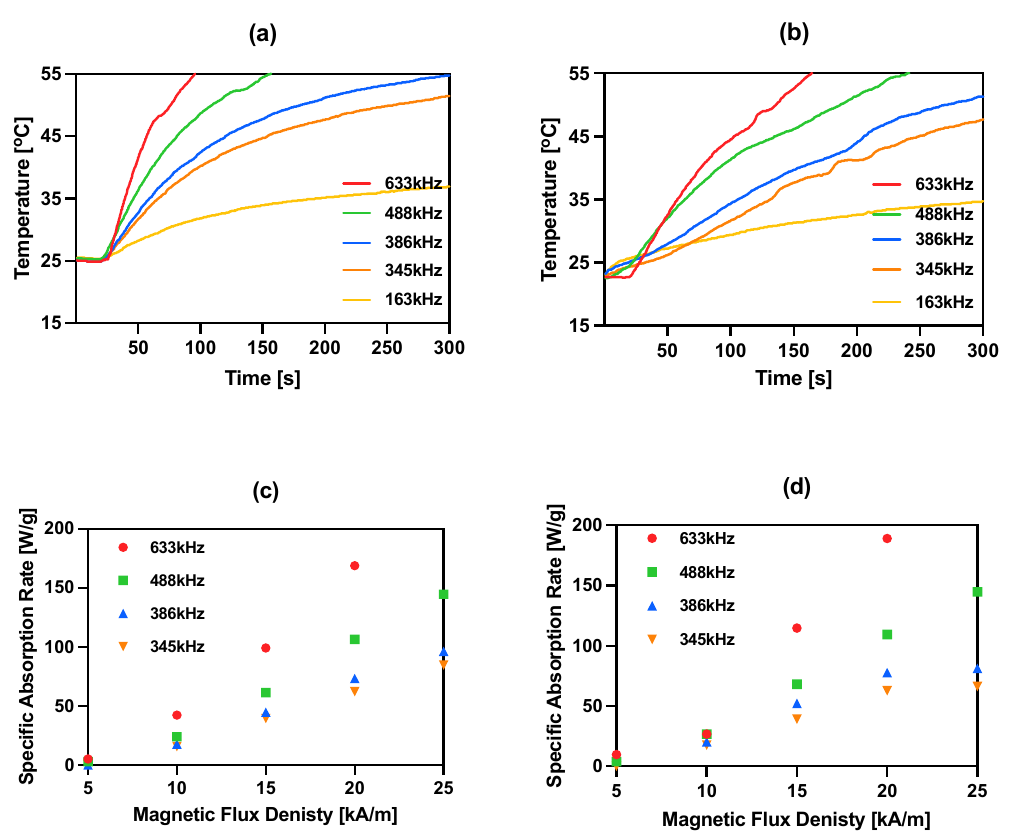
Figure 4. Heating of bioconjugates in various ranges of frequency of magnetic field: ( a ) NPs-PEG 23 kA/m; ( b ) NPs-Tmab 23 kA/m and dependence of SAR for various frequencies of the magnetic field in the function of the amplitude of magnetic field: ( c ) NPs-PEG; ( d ) NPs-Tmab.